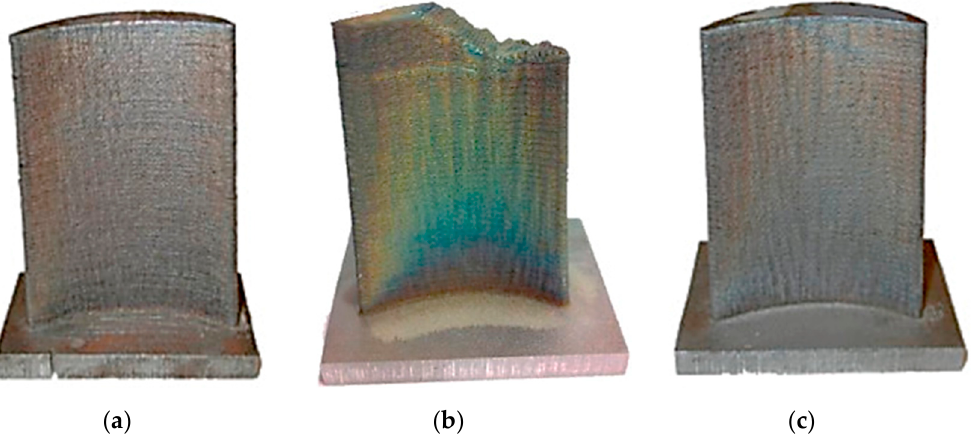
Figure 14. ( a ) Turbine blade produced by DED process, ( b ) damaged turbine blade, ( c ) restored blade by DED [18].